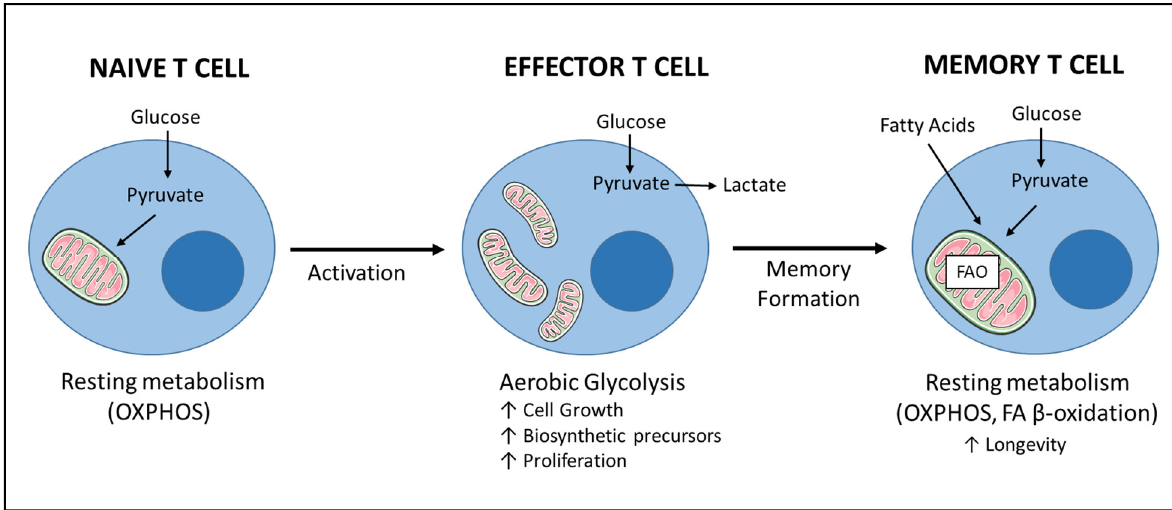
Figure 3. Simplified representation of metabolic remodeling during T cell activation and acquisition of memory phenotype. T lymphocytes exhibit distinct energy demands according to their differentiation status. Naïve, quiescent T cells predominantly use a resting metabolism relying on oxidative phosphorylation (OXPHOS) to produce ATP: the majority of pyruvate derived from glucose and other fuels (not shown) enters the mitochondria. Early after activation, effector T cells switch to a more glycolytic state to sustain cell growth and proliferation: glucose is mainly fermented into lactate; mitochondria appear punctate. After memory formation, T cells acquire a quiescent metabolic state predominantly fueled by β-oxidation of fatty acids (FAO) that ensures longevity after priming. Memory T cells are also characterized by a highly fused mitochondrial network. Note: there is an ongoing debate whether memory T cells derive from effector T cells, and/or directly from naive precursors after T cell activation. For clarity we have represented the first option, while not excluding the latter.